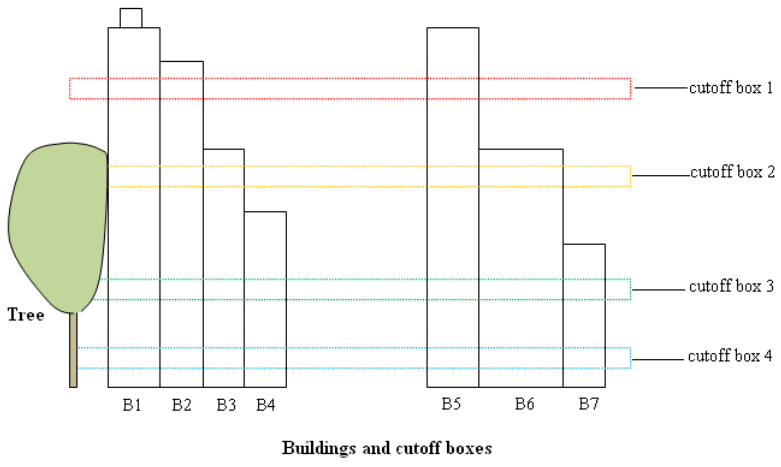
Figure 7. The basic principle of the algorithm of building point classification.